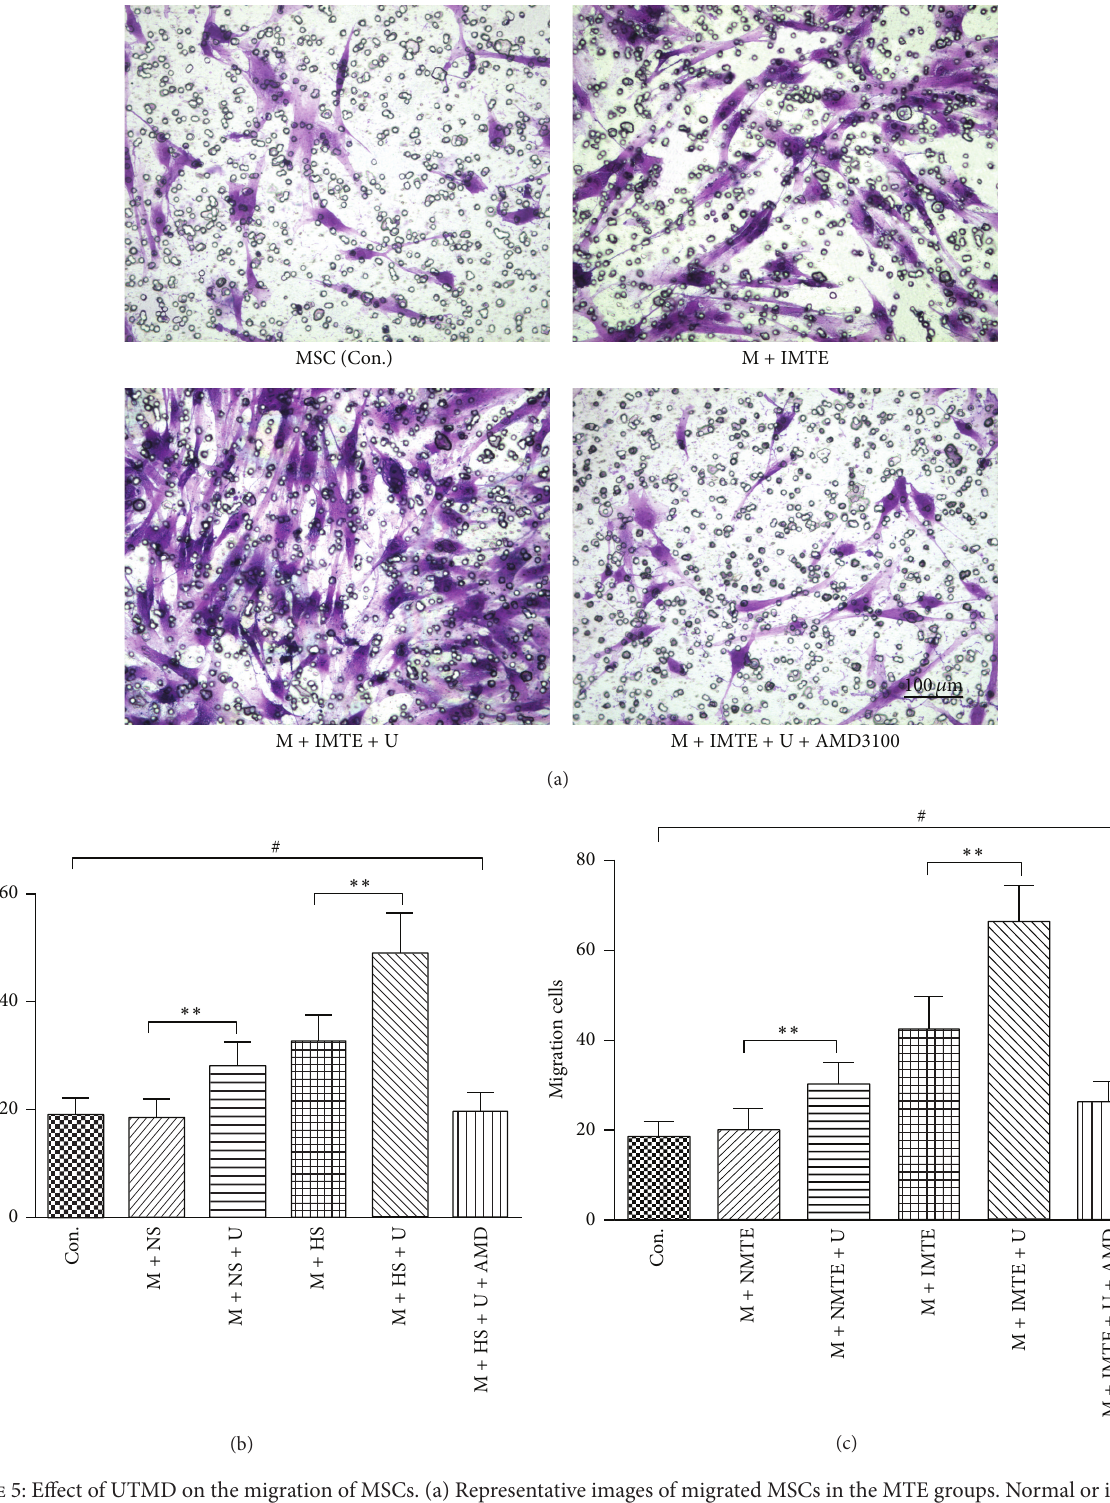
Figure 5: Effect of UTMD on the migration of MSCs. (a) Representative images of migrated MSCs in the MTE groups. Normal or infarcted myocardial tissue extracts were present in the lower chamber. The migrated cells were stained by crystal violet and observed under a light microscope. (b) Quantification of migrated MSCs in the supernatant groups. (c) Quantification of migrated MSCs in the MTE part groups. The scale bar represents 100 𝜇 m. All values are expressed as the mean ± SD. ∗∗ 𝑃 < 0.01 ; # 𝑃 > 0.05 ; 𝑛 = 3